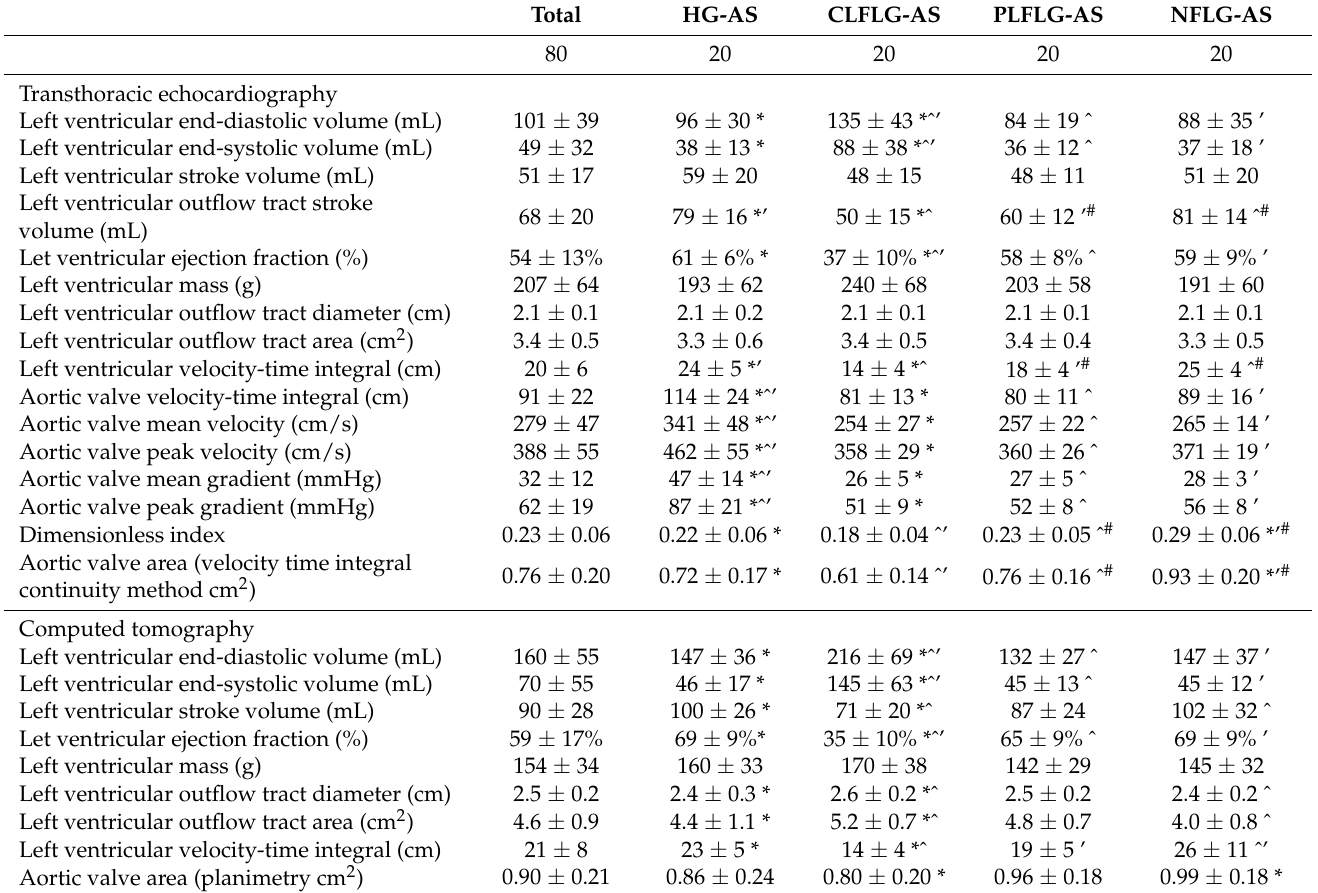
Table 2. Echocardiography and computed tomography parameters of the cohort and aortic steno- sis